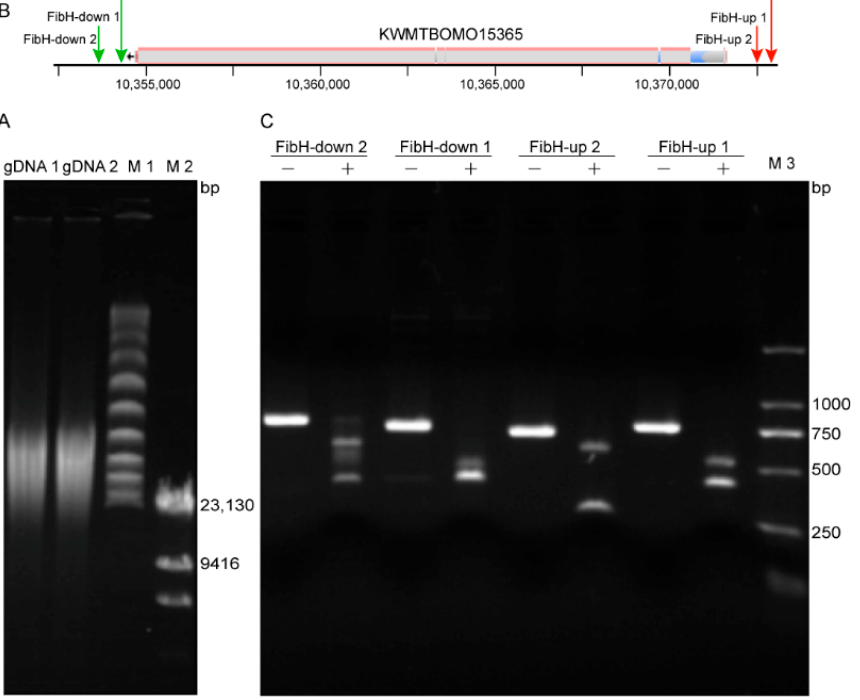
were ligated, and finally, ONT sequencing was performed using PromethION.